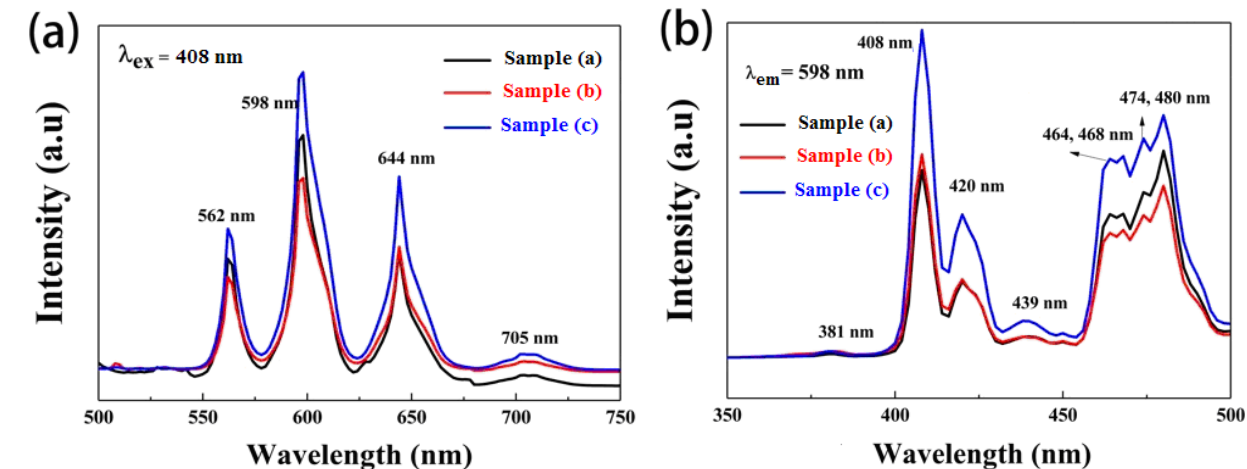
Figure 8. The emission spectra ( a ) and excitation spectra ( b ) of the different crystal sample wafers.